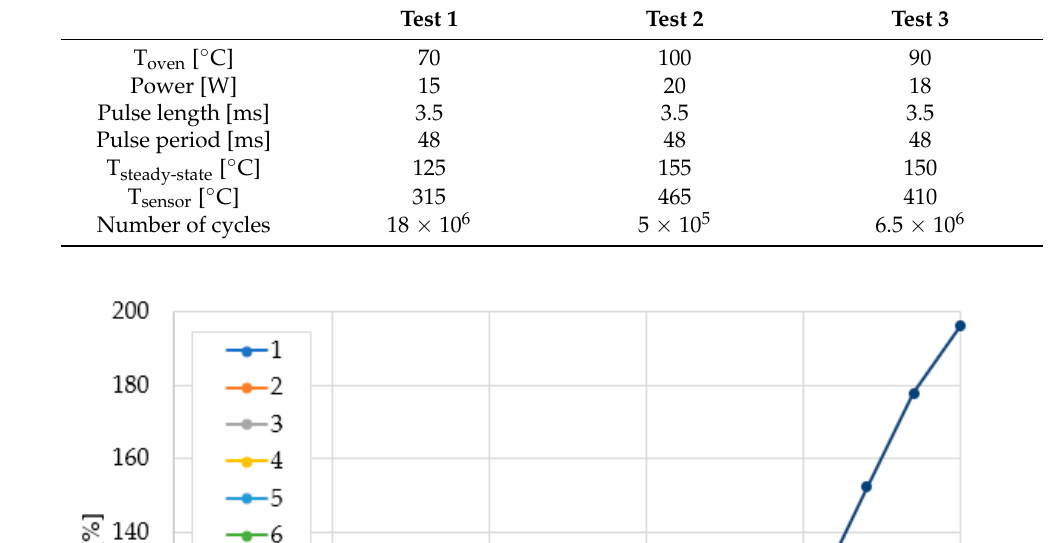
Table 1. Testing conditions for trial.